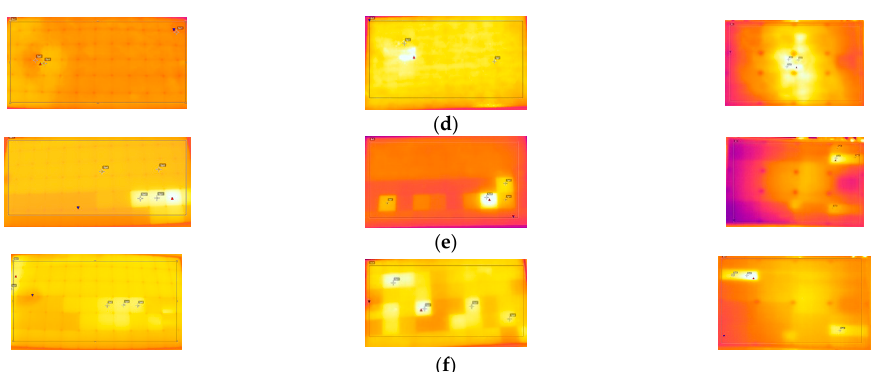
Figure 8. Thermal images of the 365 W (left), 220 W (middle), and 35 W (right) panels after different failure types: ( a ) hotspot, ( b ) diode failure, ( c ) connector breakage, ( d ) panel breakage, ( e ) busbar, and ( f ) overheating of panel cells.